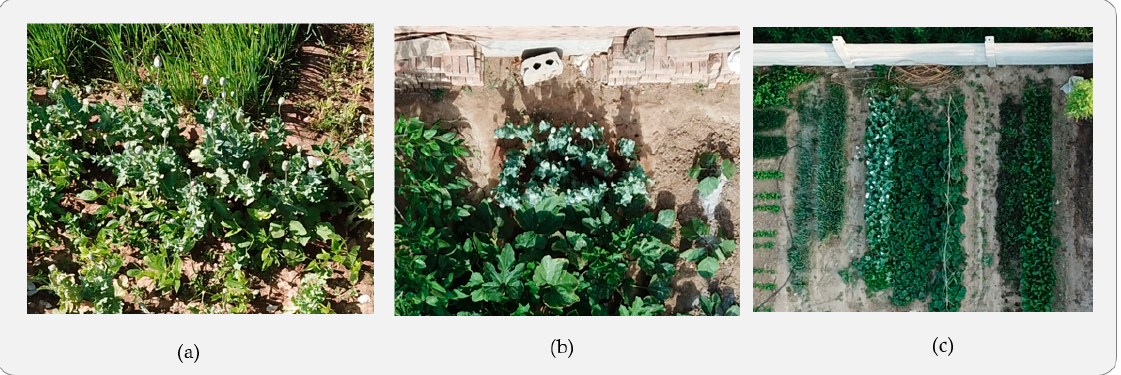
Figure 1. Poppy images have differences in ( a ) shooting, ( b ) light intensity and ( c ) different